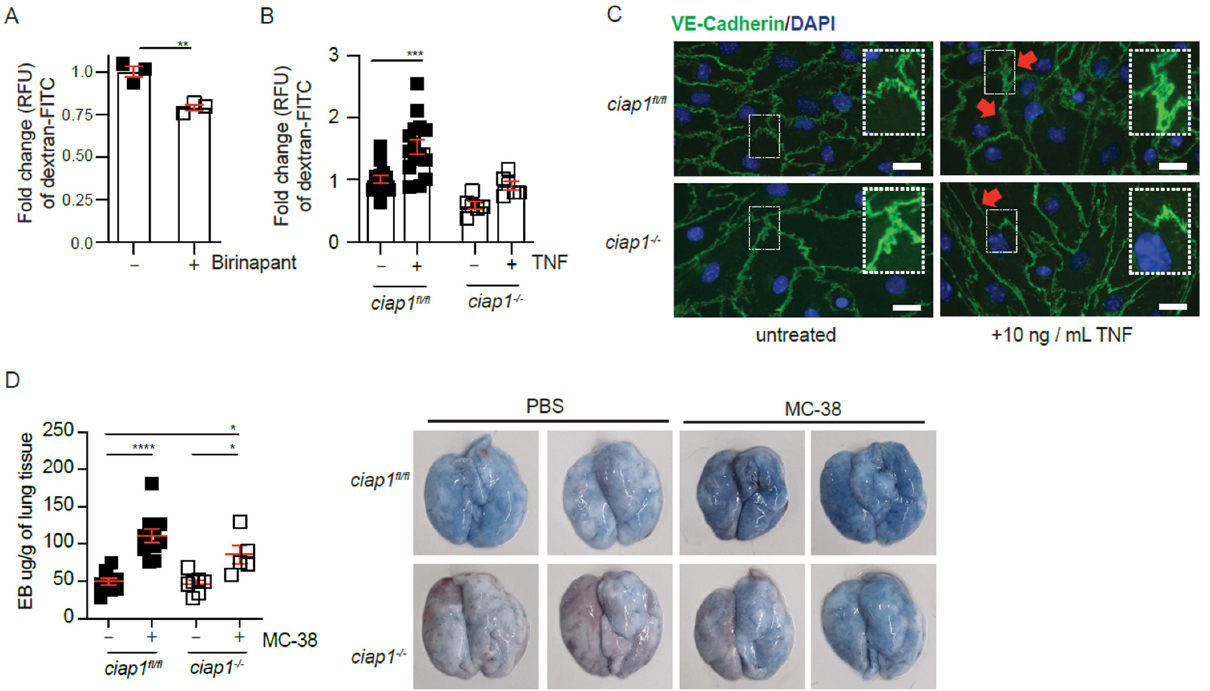
Figure 5. cIAP1 loss in the endothelium barrier affects permeability. ( A ) HUVEC monolayers were pre-treated with birinapant for 16 h before permeability to dextran-FITC was assessed (30 min). n = 3 transwells/condition ( B ) Primary isolated lung endothelial cell (EC) monolayers were stimulated with mouse TNF (TNF) for 18 h before permeability to dextran-FITC was assessed (30 min). Control cells were treated with DMSO or left untreated; n = 4 experiments with biological replicates. ( C ) Immunofluorescence staining of primary isolated lung ECs with DAPI (blue) and primary antibody against VE-Cadherin (green) treated with TNF for 18h. Scale bars: 20 µm. ( D ) Permeability assessment in vivo by Evans blue assay 6 h after injection of MC-38. Representative pictures of lungs after injection of Evans blue are shown. Each dot represents an individual mouse. Data are presented as mean ± SEM. * p < 0.05; ** p < 0.01; *** p < 0.001; **** p < 0.0001. Two-tailed unpaired t -test ( A ), one way ANOVA with multiple comparison ( B , D ).